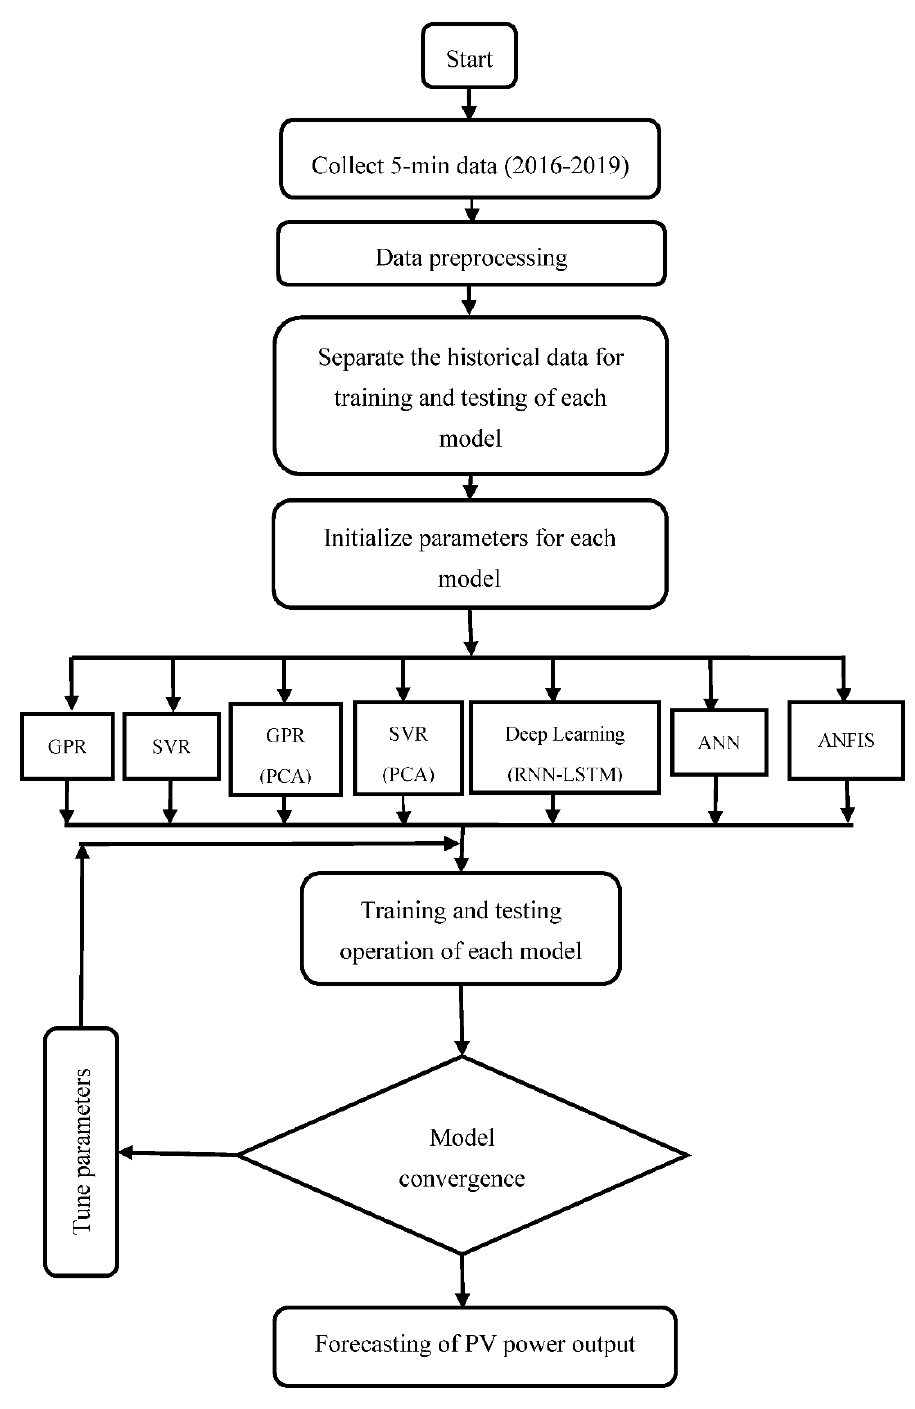
Figure 2. An overall methodology flow chart.